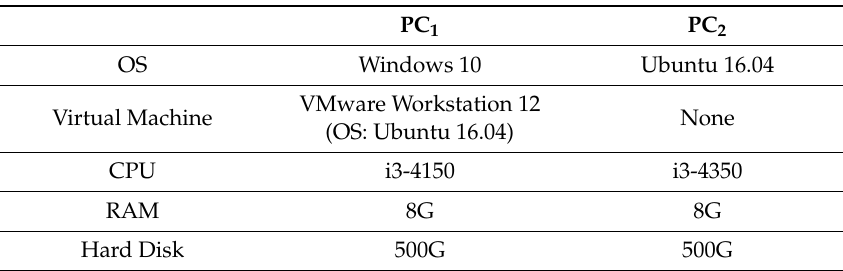
Table 2. The specification of the